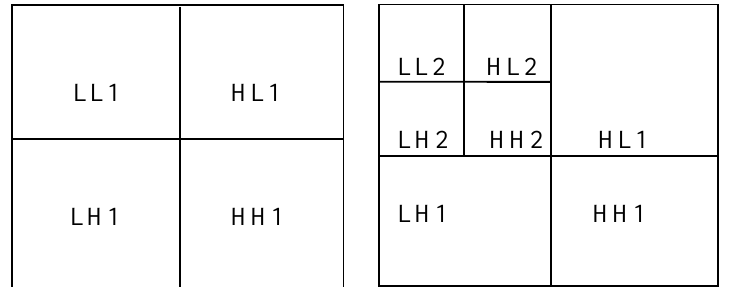
Fig. 1. Sub band for one level and two level of decomposition